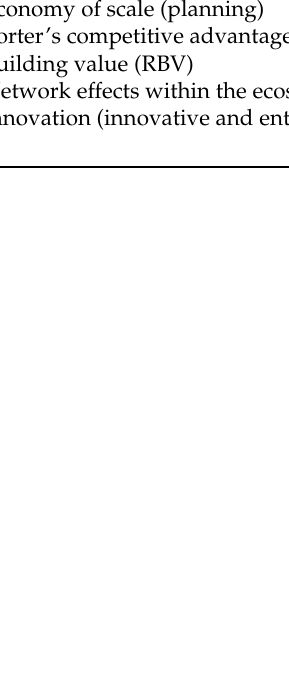
Table 11. Share of approaches to the strategy according to the indicator of achieved rents (%